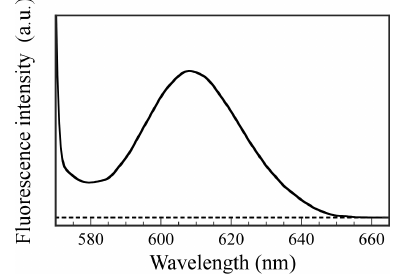
Figure 10. Fluorescence emission spectra for Dex after dialysis against PBS buffer for 18 h excited at 550 nm in the presence ( ── ) and absence (----) of PICsomes in PBS buffer